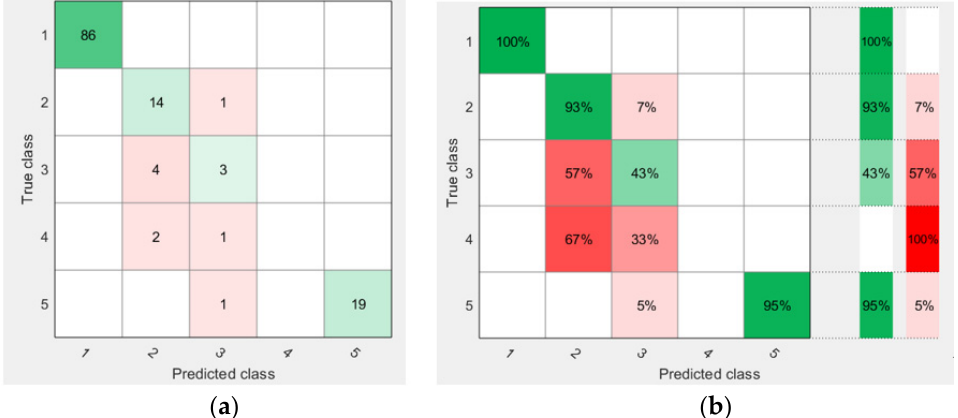
Figure 9. Confusion matrix of ensemble bagged tree: ( a ) the confusion matric explaining the correct number of samples in each class and ( b ) the classification accuracy of each class.